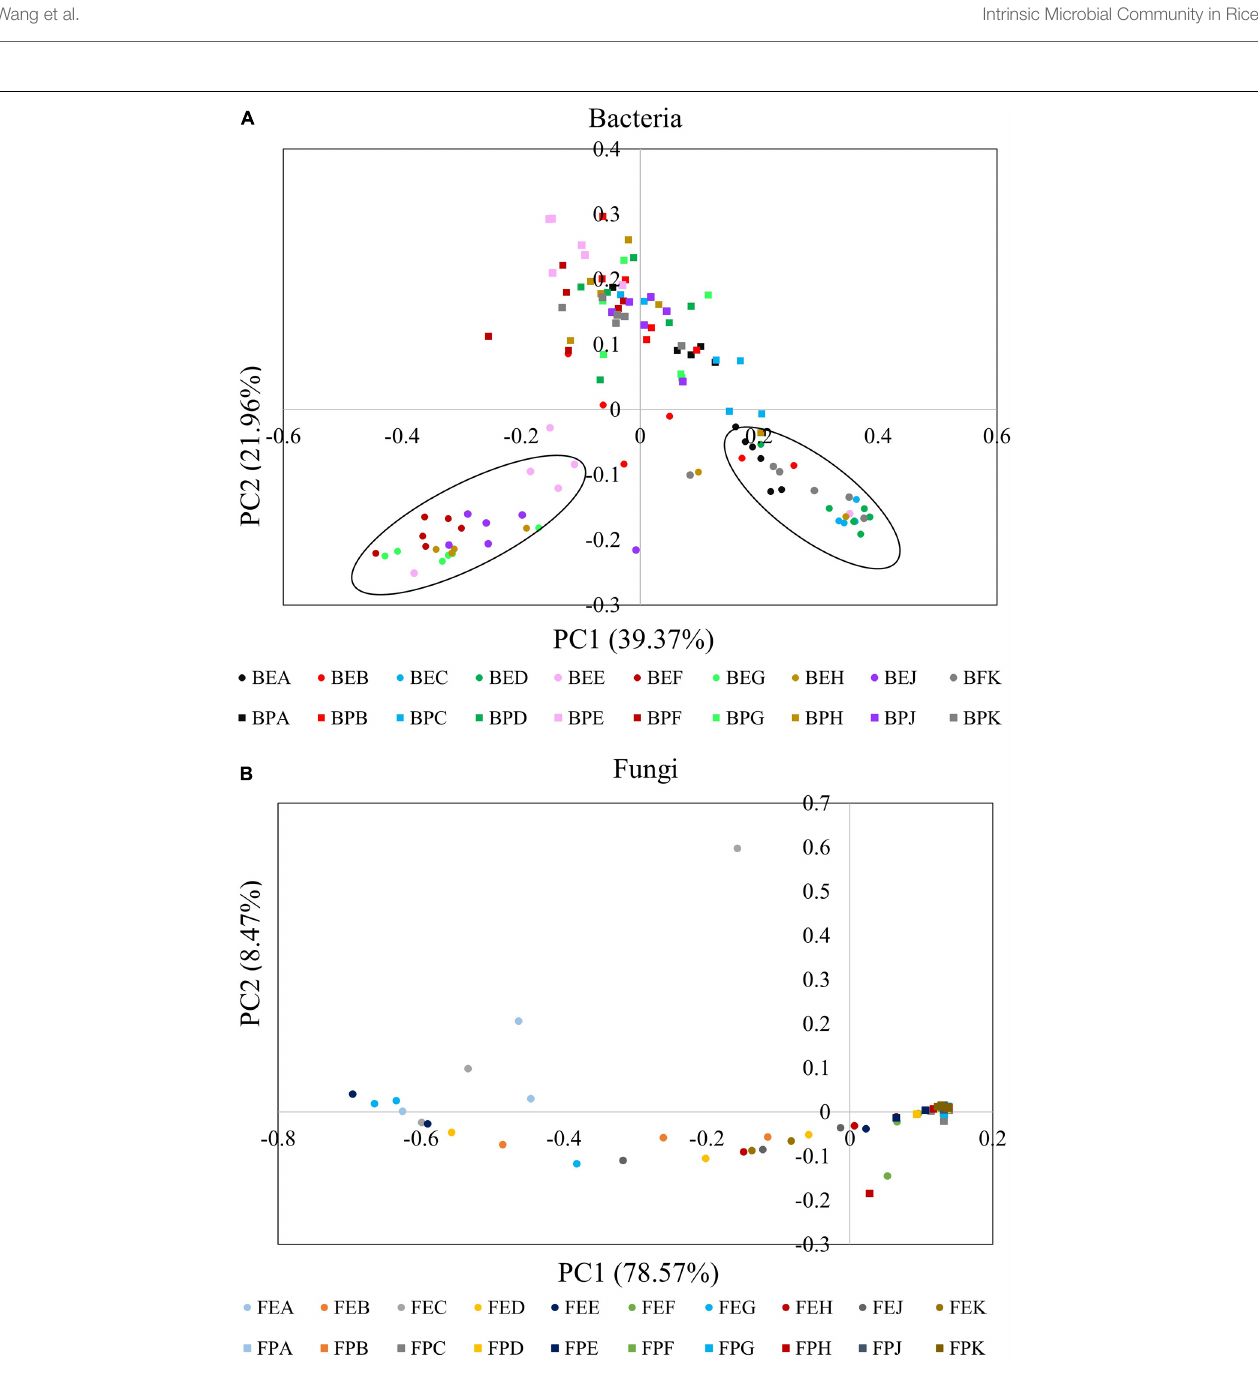
FIGURE 3 | Principal coordinate analysis (PCoA) plots based on weighted UniFrac matrix of bacterial (A) and fungal communities (B) . The initial letters B and F stand for bacterial and fungal, respectively. The middle letters E and P stand for endosphere and phyllosphere, respectively. The last letter A–K designate the implemented